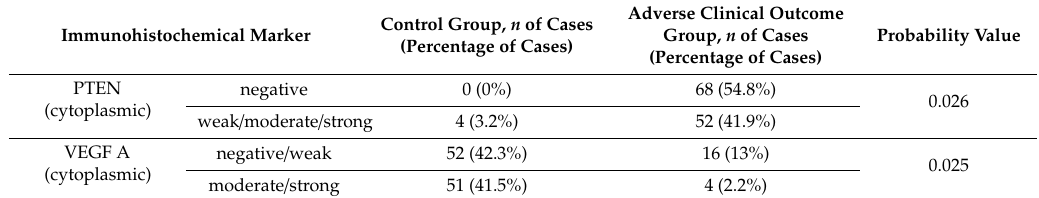
Table 5. Correlation of relapse free survival and alteration of intensity in immunohistochemical staining (univariate